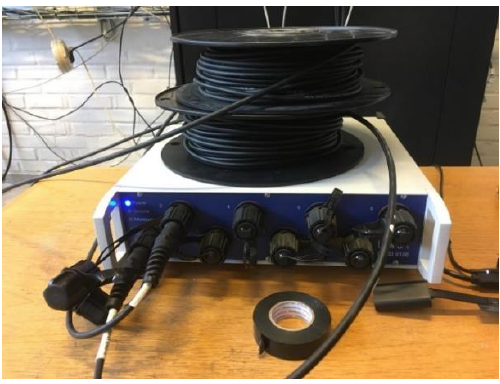
Figure 1. LUNA’s ODiSI 6000 Optical Backscatter Reflectometer.